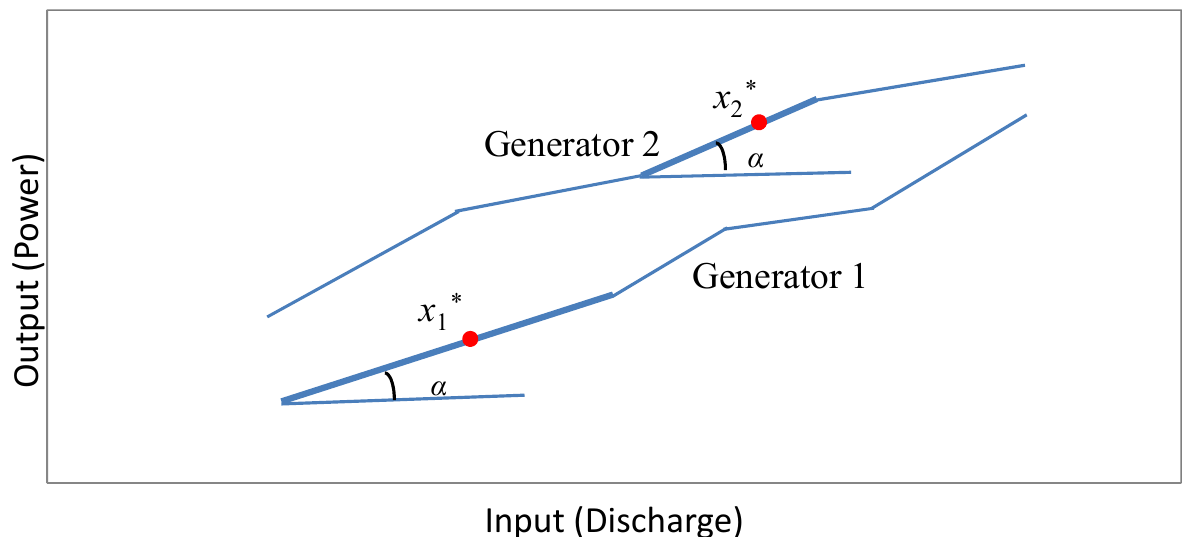
Figure 1. An example showing that multiple solutions might exist in the OLD